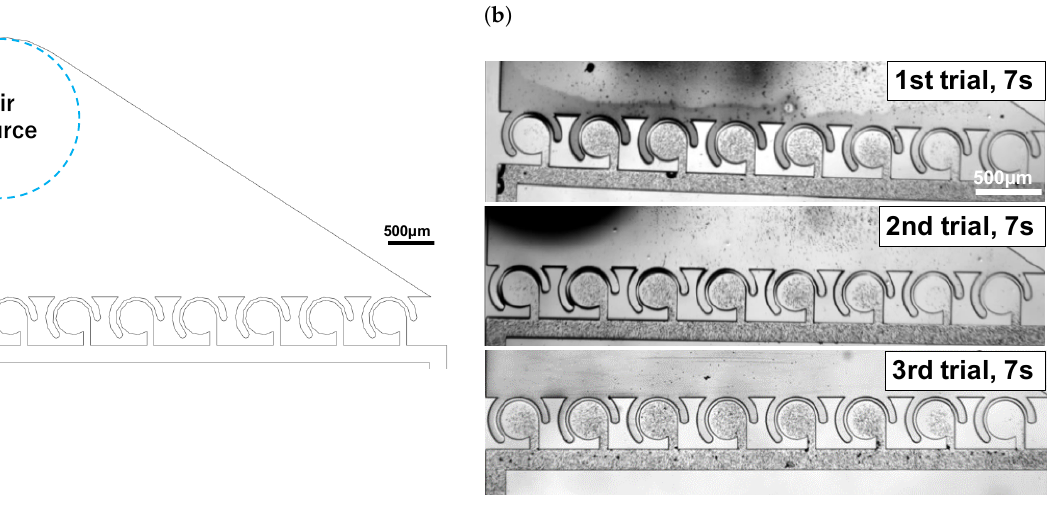
Figure A4. Flow path without the effect of channel width. ( a ) Concentration gradient was generated by the pressure gradient after removing the effect of the channel width. ( b ) Experimental results. Concentration gradient was generated, but concentrations in the chambers at both ends were